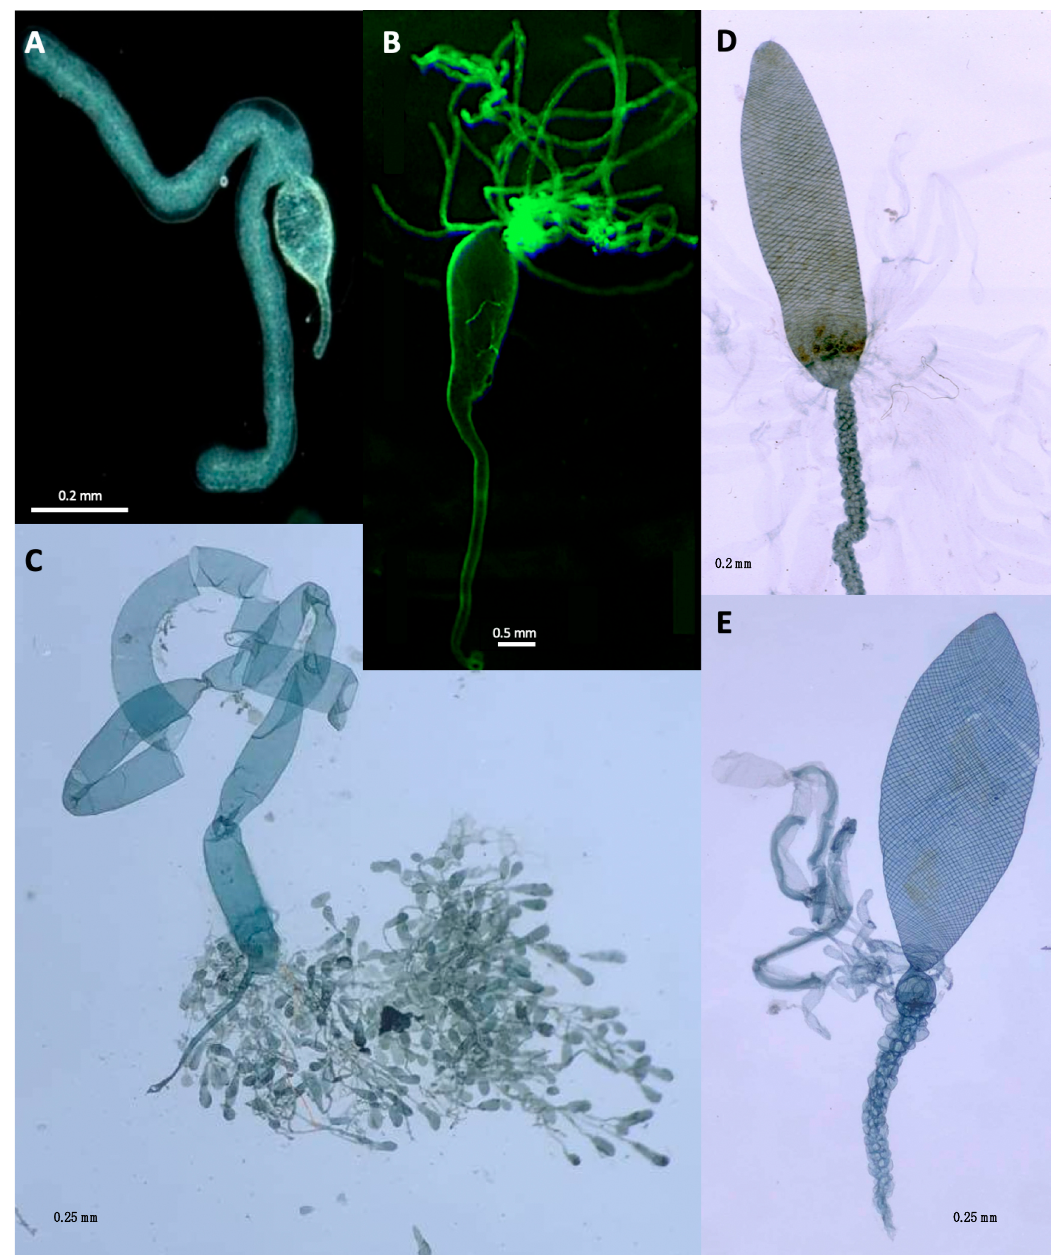
Figure 2. Dissected venom glands and reservoirs or their chitinous intima. ( A ), dissected venom glands and reservoir of Diadromus collaris (Ichneumonidae: Ichneumoninae) from [56] (Reproduced under the terms of Creative Commons Attribution Licence CC-BY 4.0 via Scientific Reports ), scale bar: 0.2 mm; ( B ), dissected venom glands and reservoir of Pimpla turionellae from [57] (Reproduced under the terms of Creative Commons Attribution Licence CC-BY 4.0 via Toxins ), scale bar: 0.5 mm; ( C – E ), chlorozol black dyed reservoir, gland and primary duct chitinous intima: ( C ), gen. sp. (Doryctinae), scale bar: 0.25 mm; ( D ), Bracon sp. (Braconinae), scale bar: 0.2 mm; ( E ), Iphiaulax , unidentified species (Braconinae), scale bar: 0.25 mm.